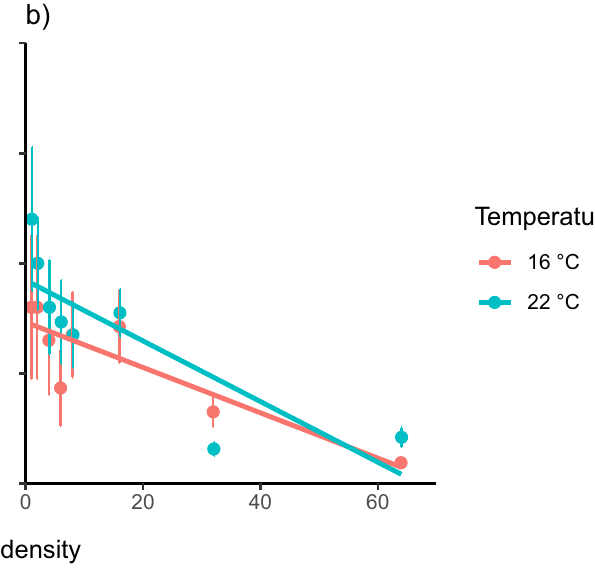
Figure 1. Proportion of killed Mytilus edulis across two temperatures, eight prey densities and two sexes by Hemigrapsus takanoi (males, a ; females, b ). Salinity levels were combined, as salinity was not statistically significant. Points representing the proportion of mean killed prey at each density level ± standard error (SE).